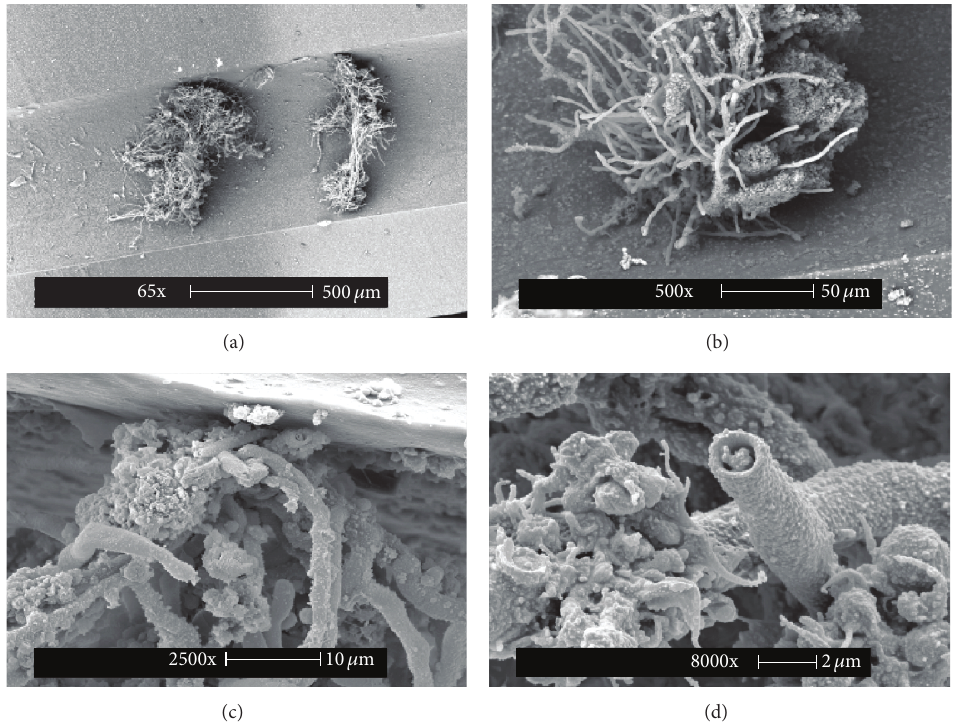
Figure 2: Scanning electron microscopy images of the tip and cuff of the central venous catheter removed from a child with intermittent fever of unknown origin. (a) Mycelial formation in the catheter lumen. Of note is the long fungal protrusion into the lumen. ((b) and (c)) Magnifications show adhesion of the fungal formation to the inner surface of catheter. (d) Detail of the aerial